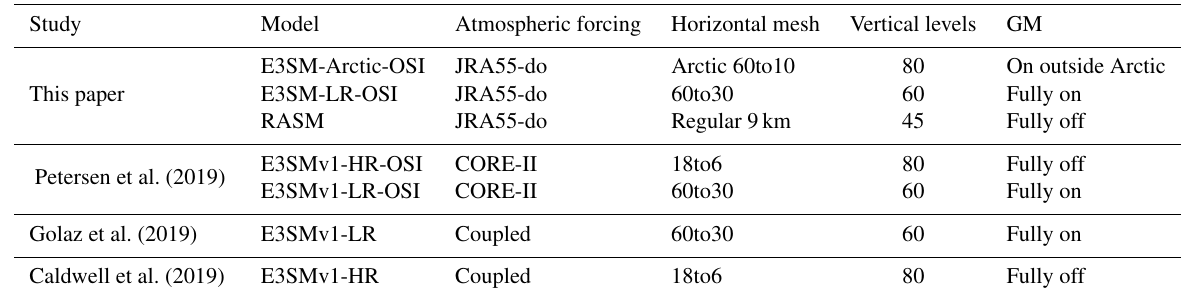
Figure 1. (a) Distribution function used to define cell size as a function of latitude and create the meshes: red curves indicate the E3SM- Arctic mesh, whereas the black curve indicates the E3SM-LR mesh. The solid red line marks resolution changes in the Atlantic Ocean and the dashed red line marks changes in the Pacific Ocean. Note that all lines converge (same behavior everywhere for both E3SM-Arctic and E3SM-LR) in the Southern Hemisphere. (b) Geographical distribution of grid cell size for the E3SM-Arctic-OSI configuration. The area between the white and red lines denotes the region where the transition between GM-on and GM-off occurs (no GM eddy parameterization is used north of the red lines). (c) Zoom-in around the Arctic of a salinity field simulated in E3SM-Arctic-OSI, with a further enlargement around Ellesmere Island to show the hexagonal mesh in more detail. Also shown are the locations of the five Arctic gateways and Davis Strait, through which fluxes in and out of the Arctic are later calculated. Table 1. Main configuration differences between the model experiments described in this paper and those described in key E3SMv1 (ver- sion 1) publications. Numbers used in the “horizontal mesh” column refer to the minimum and maximum resolutions in kilometers for E3SM cases, while we have indicated that a regular 9km resolution mesh is used for the RASM